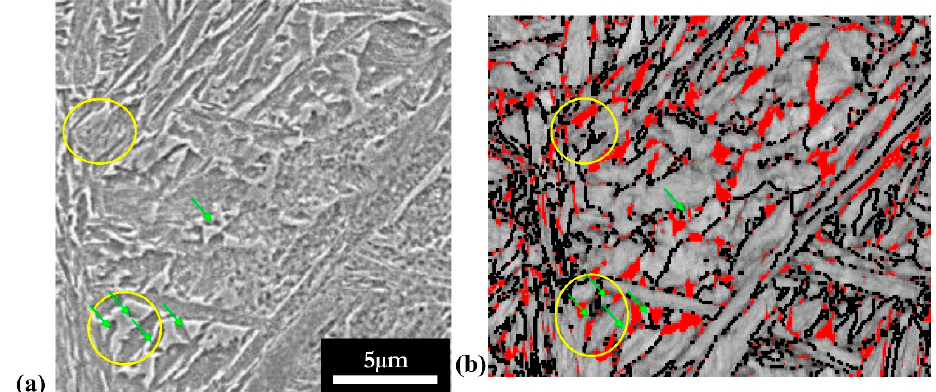
Figure 13. Zoom of Zone 1 in Figure 12. ( a ) SEM image ( b ) Band contrast and 10° grain boundaries (in black) together with retained austenite (in red) of the same zone than ( a ) obtained by EBSD. Yellow circles: martensite/austenite (MA) islands. Green arrows: bainite.